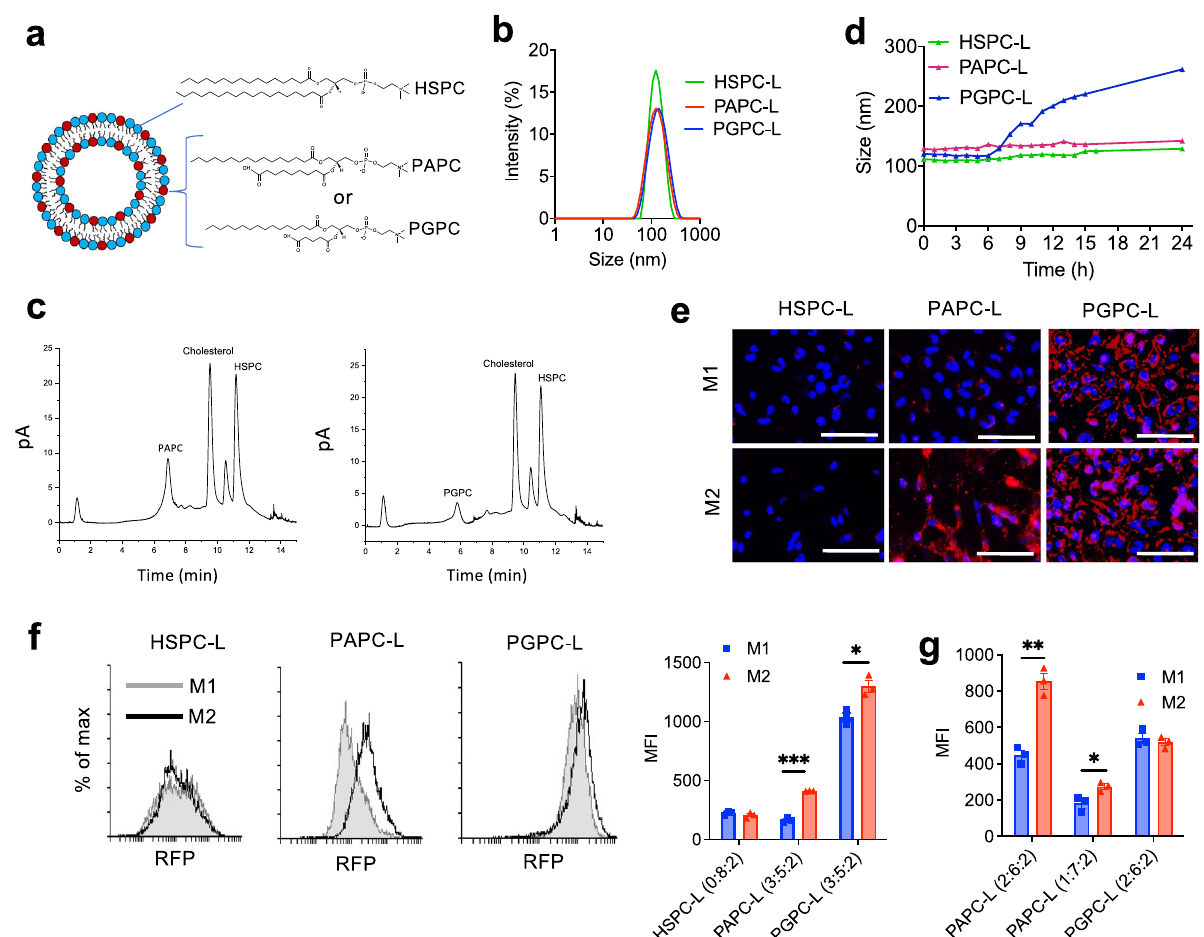
Fig. 1 | Characterization and uptake of M2-targeted nanoliposomes. a Representative illustration of nanoliposomes showing incorporation of HSPC, PAPCandPGPCphospholipid. b Typicalhistogramshowingthesizedistributionof HSPC nanoliposomes (HSPC-L, HSPC:Cholesterol=8:2), PAPC-L